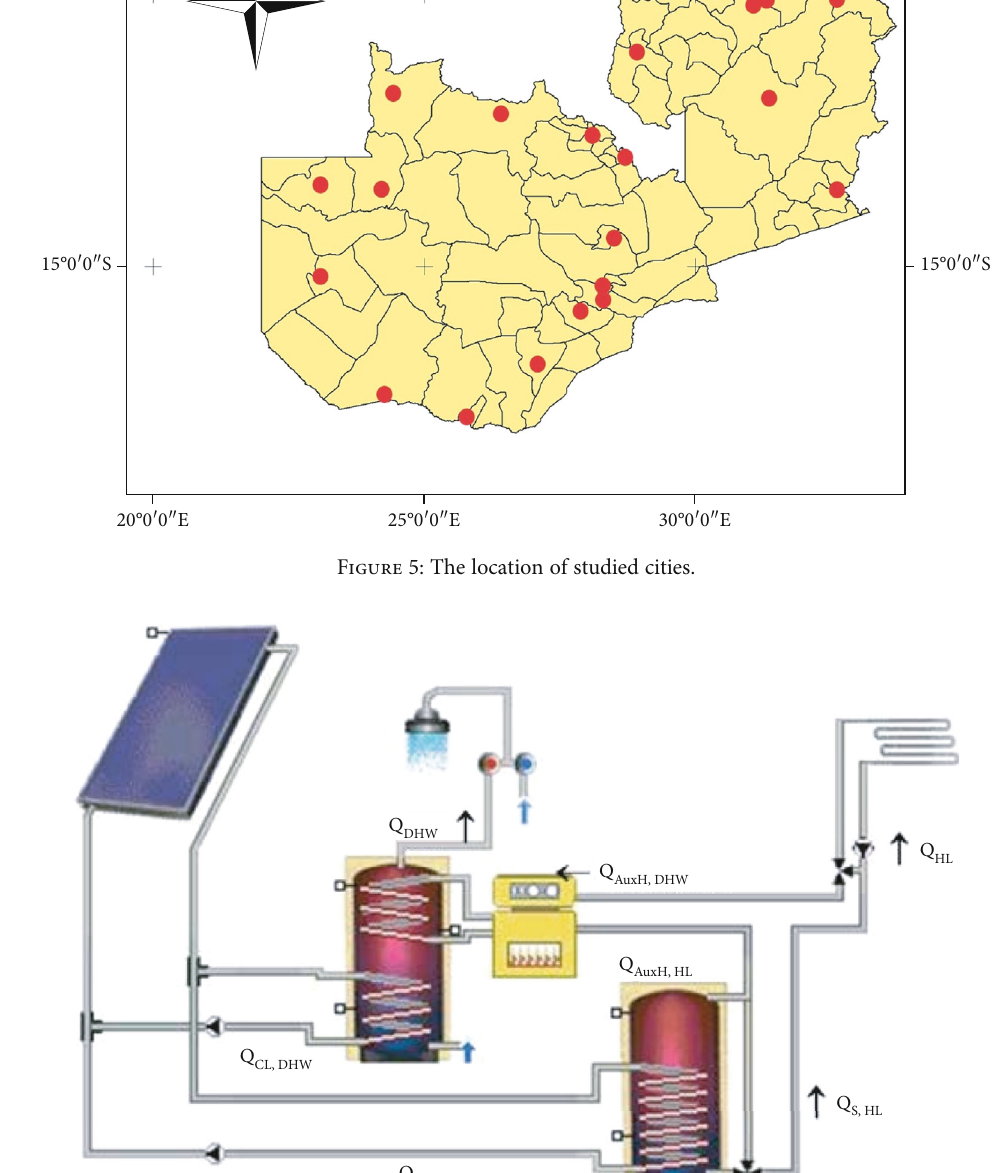
Figure 6: Schematic of the solar system with a bivalent storage tank (internal heat exchanger). DHW: domestic hot water; S,HL: solar heating load; HL: heating load; AuxH: auxiliary heating; CL: collector